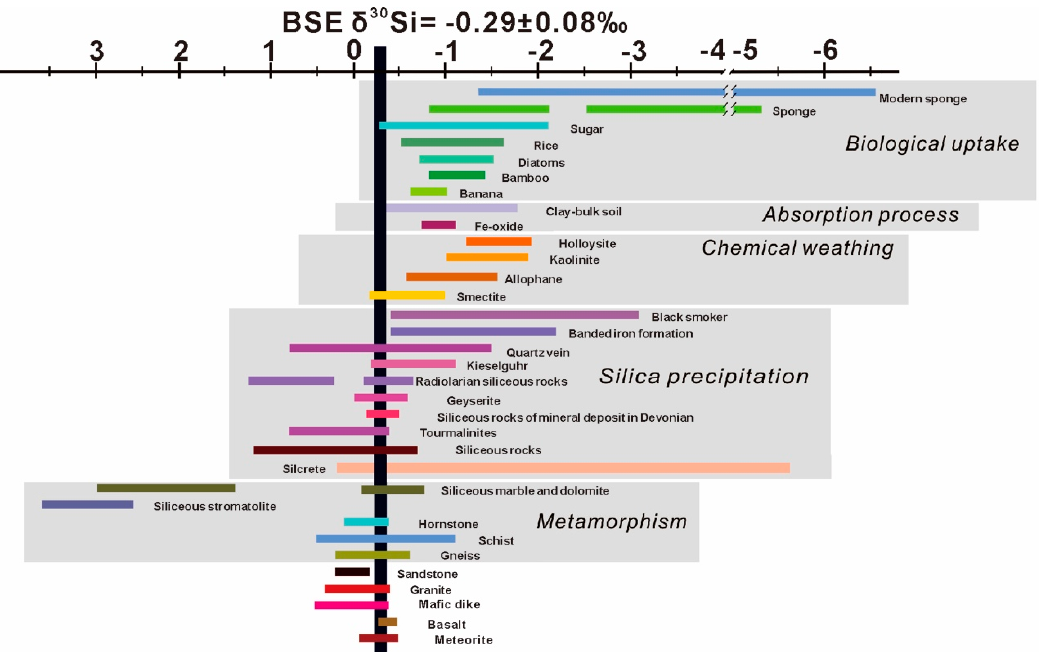
Figure 1. Silicon isotope variations as function of host rocks, organisms, and corresponding geological processes in nature (modified with permission from Wang et al. [78], Langmuir, published by ACS, 2016).